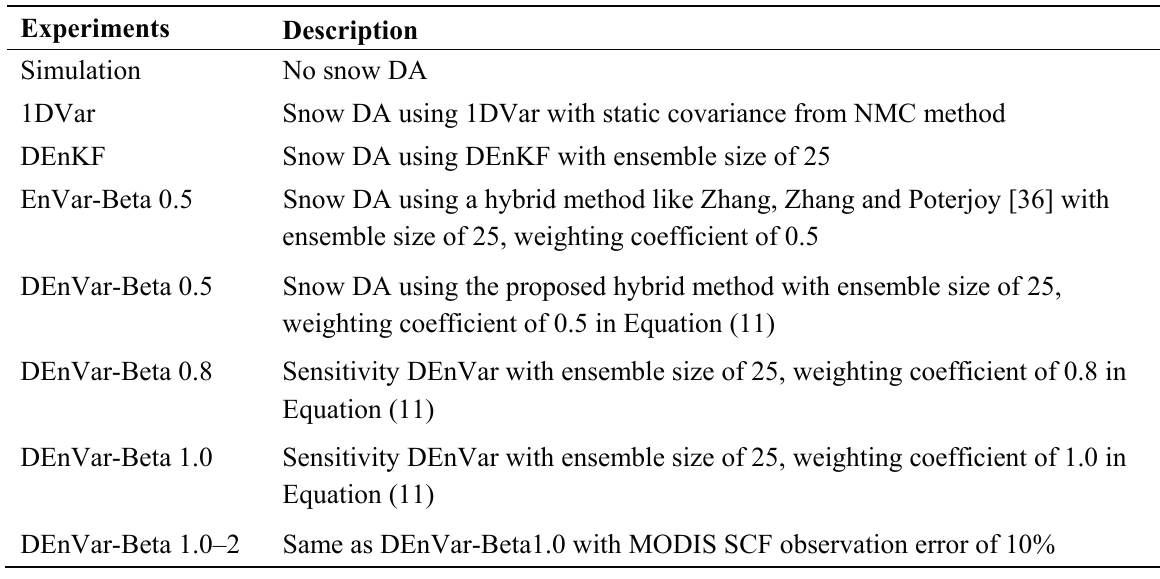
Table 2. Summary of snow DA experiments. Note that the SCF observation standard errors of these DA experiments except for the DEnVar-Beta 1.0–2 experiment are given in Table